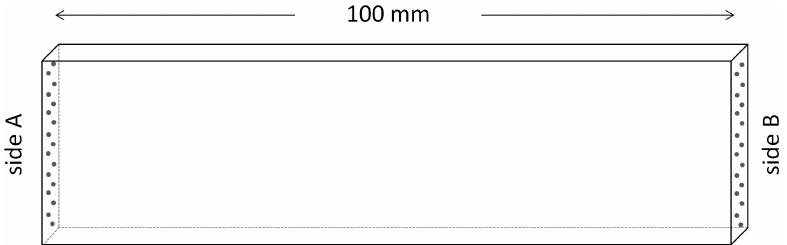
Figure 3. Sketch of the results of a tactile gauge block measurement.